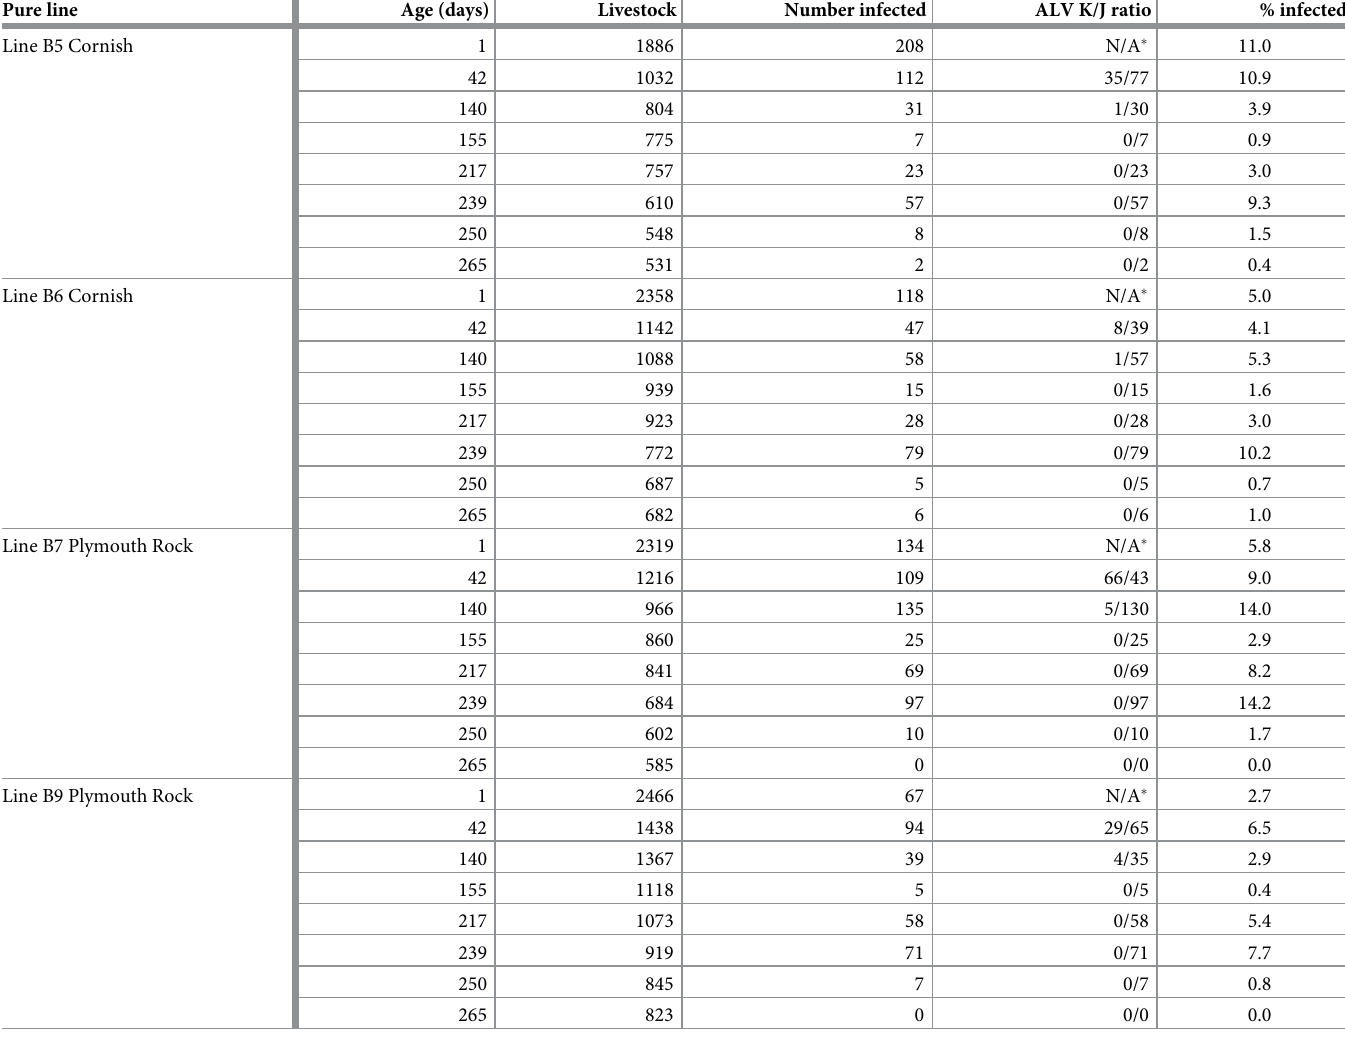
Table 2. ALV eradication in the 77 th generation of Smena8 broiler cross pure lines. Pure line Age (days) Livestock Number infected ALV K/J ratio % infected Line B5 Cornish